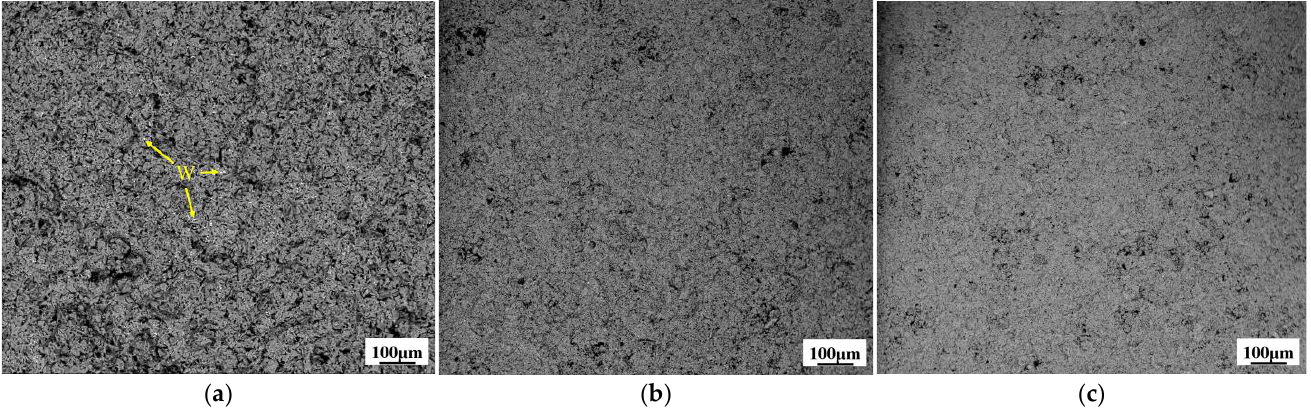
Figure 7. Surface SEM images of W – Cu composite coatings under different reverse duty cycles: ( a ) d r = 5%, ( b ) d r = 10%, and ( c ) d r = 15%, ( J = 2 A/dm 2 , f = 1500 Hz and d f = 40%).